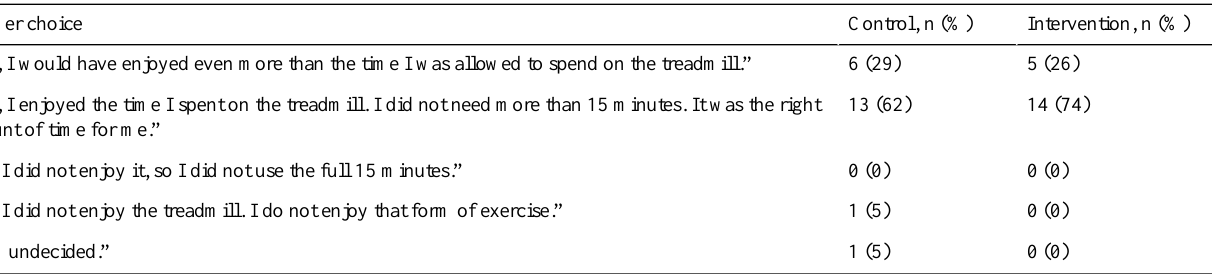
Table 3. Patients’response to “During most of your treatment sessions, you were allowed to use the treadmill for up to 15 minutes. Did you enjoy the time spent on the treadmill?”